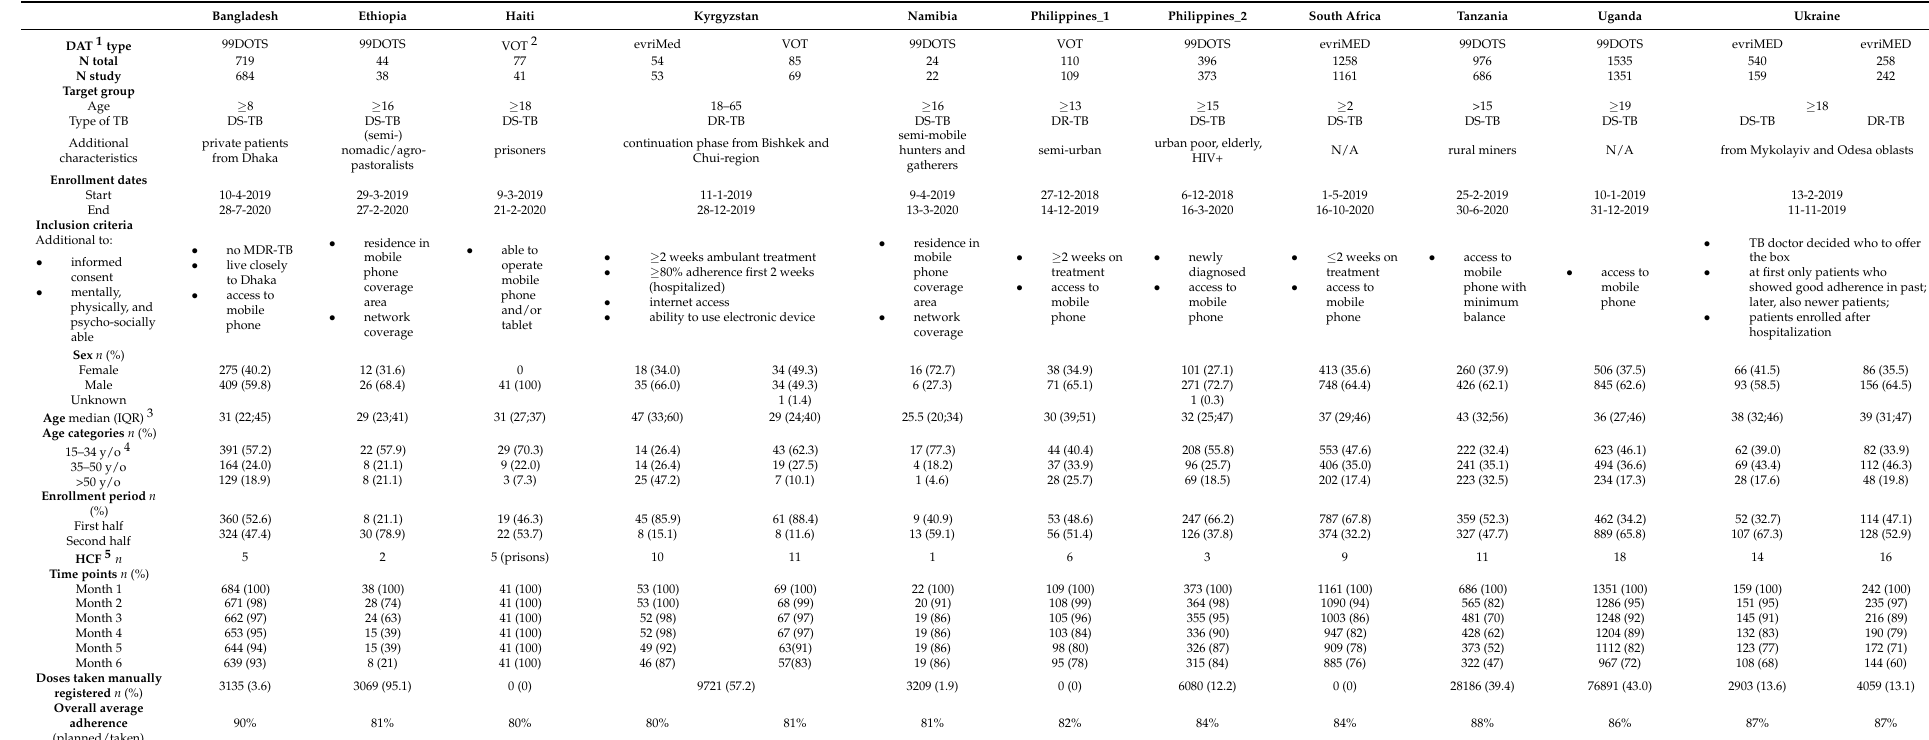
Table 1. Overview of the eleven DAT projects and their enrolled